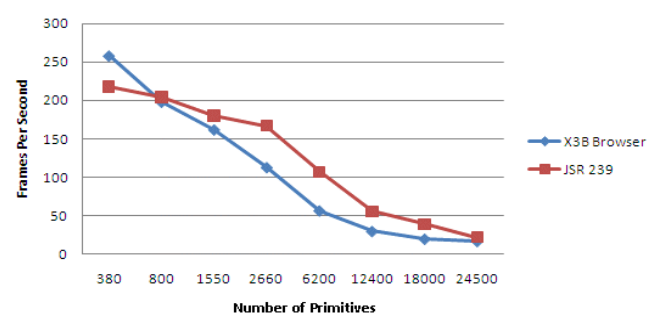
Figure 10. Variation of frame rate for each environment according to the variation of graphical primitives.